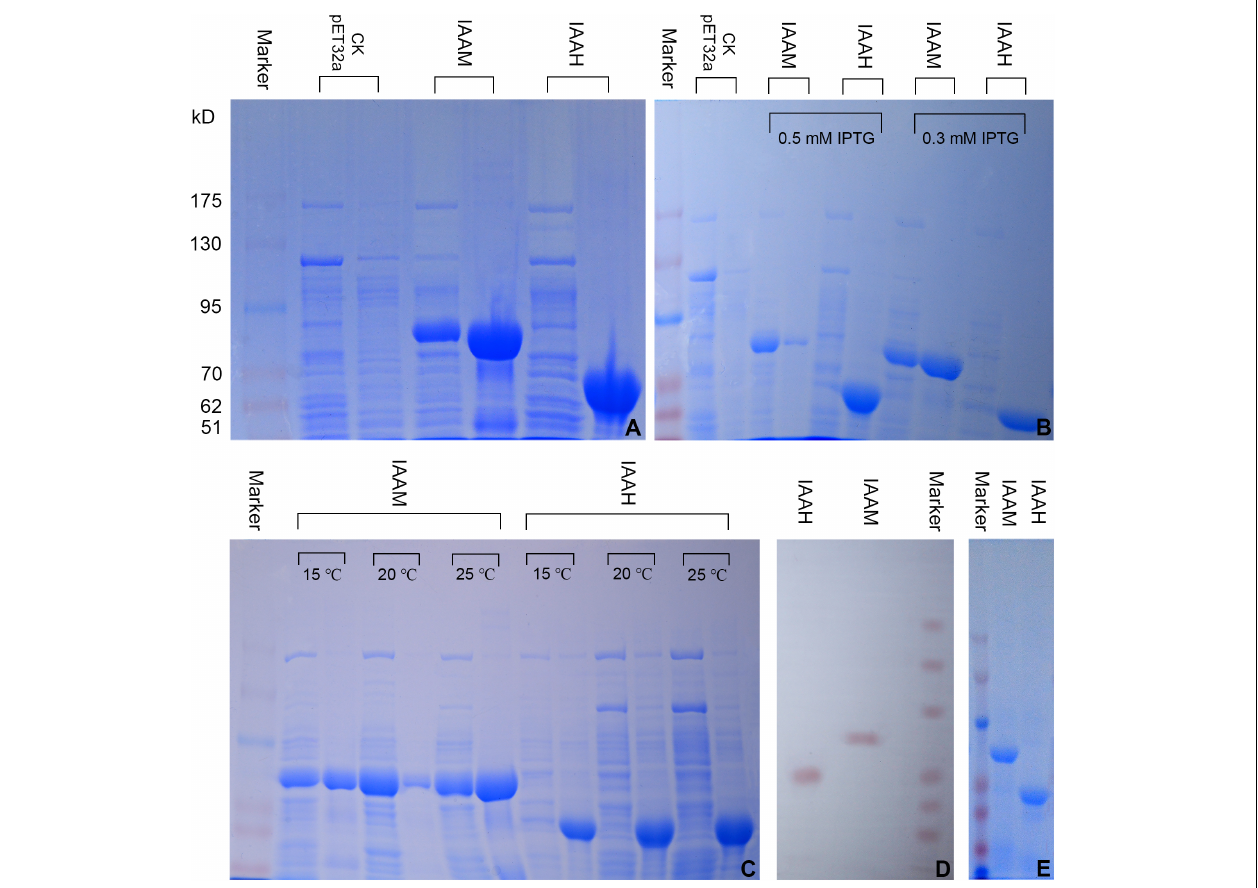
FIGURE 3 | Prokaryotic expression, purification and Western blot identification of the tryptophan 2-monooxygenase (IAAM) and indoleacetamide hydrolase (IAAH) fusion proteins. (A) Expression of tryptophan 2-monooxygenase and indoleacetamide hydrolase (Opti-Protein Marker, the sizes from top to bottom are as follows: 175, 130, 95, 70, 62, and 51 kD; for each treatment, the left lane is the supernatant and the right is the precipitate; this information is also relevant to later figures). (B) Effect of the IPTG concentration on the expression of tryptophan 2-monooxygenase and indoleacetamide hydrolase. (C) Effect of the temperature on the expression of the tryptophan 2-monooxygenase and indoleacetamide hydrolase fusion proteins. (D) Western blot analysis of tryptophan 2-monooxygenase and indoleacetamide hydrolase. (E) Purified tryptophan 2-monooxygenase and indoleacetamide hydrolase.